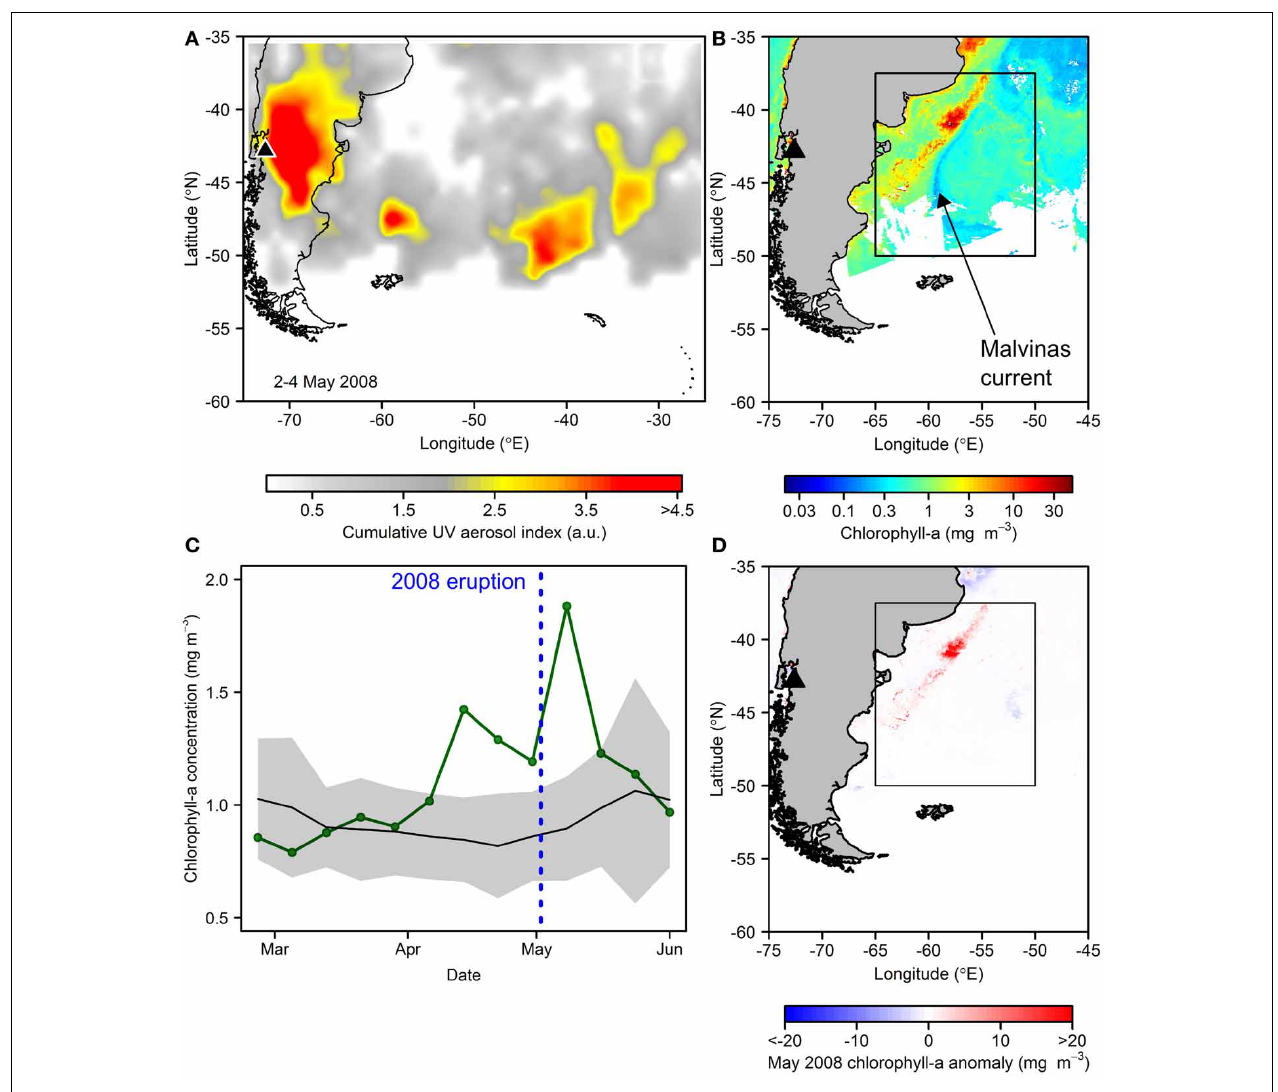
FIGURE 6 | Potential fertilization subsequent to the May 2008 Chaitén eruption. (A) Atmospheric aerosol loading for the main eruption period in May 2008 (product is UV aerosol index from EOS Aura Ozone Measuring Instrument (OMI) summed over 2–4th May 2008). (B) Satellite-derived chlorophyll-a concentrations for May 2008 showing particularly high values